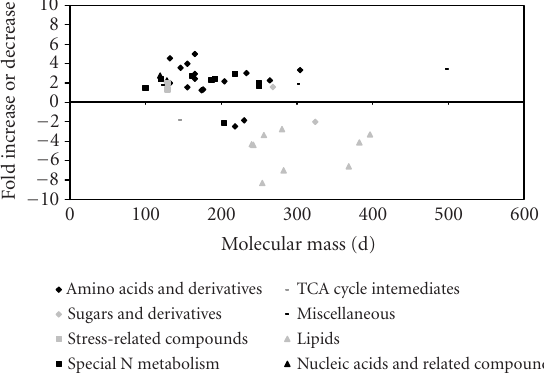
Figure 2. Scatter plot distribution of all classes of metabolites identified in leaf extracts.